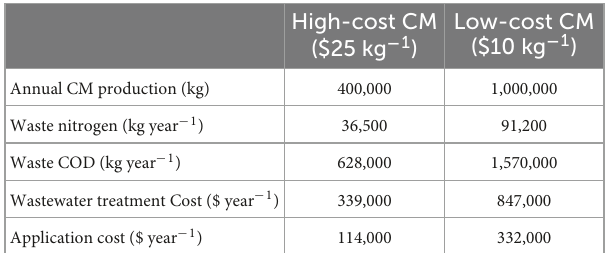
TABLE 3 Spent media nitrogen and COD production and management costs for two CM production scenarios.